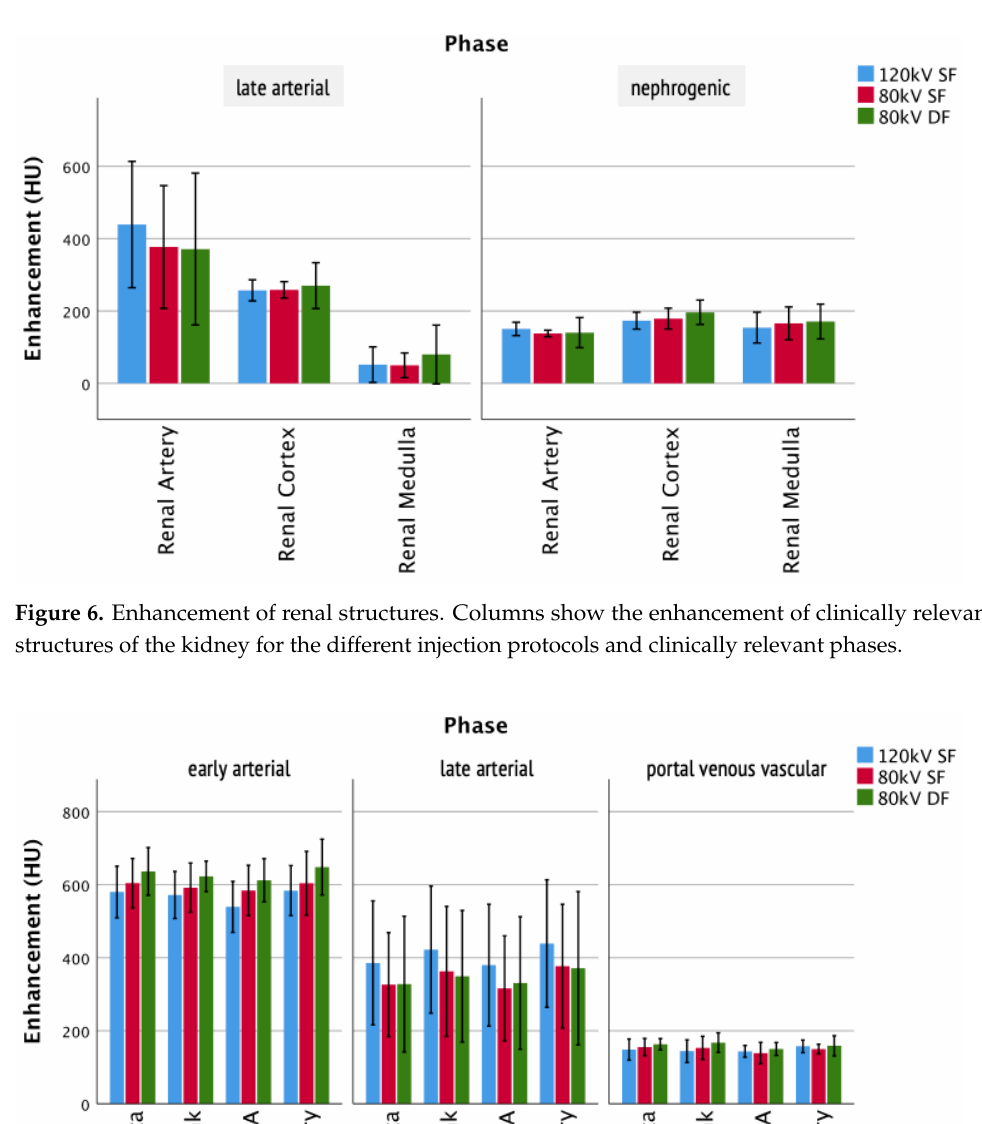
Figure 7. Enhancement of arteries. Columns show the enhancement of arteries for the different injection protocols and clinically relevant phases.